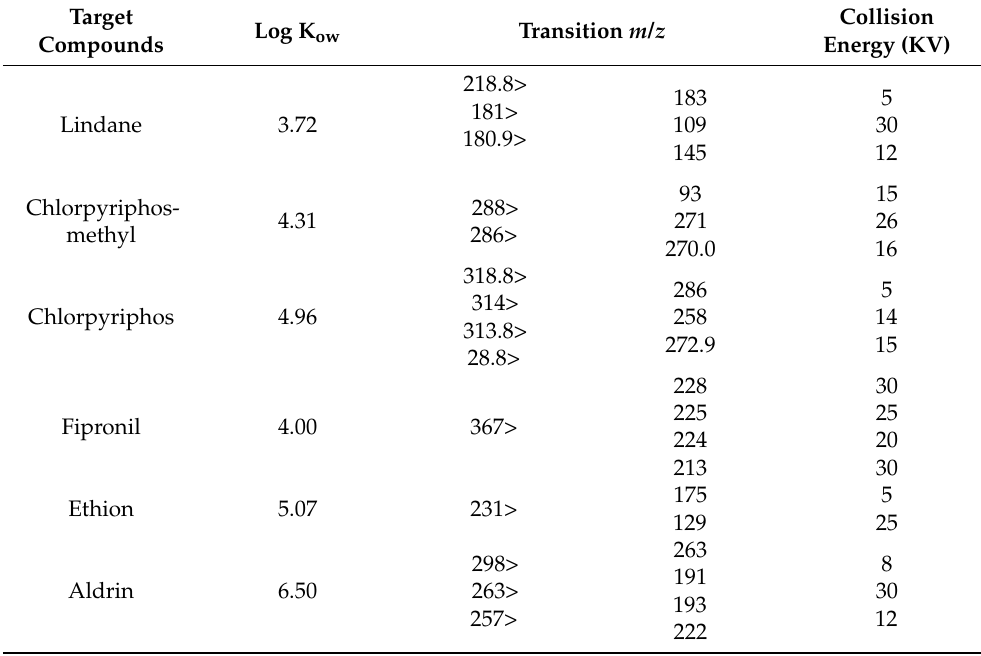
Table 1. GC-MS/MS parameters for determination of target analytes by